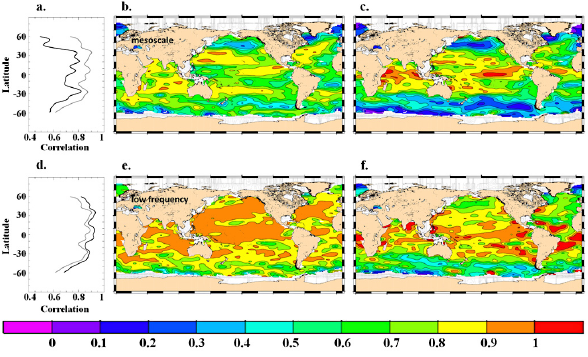
Fig. 5. Depth to which it is sufficient to integrate the DHA signals in order to explain 80% of the variance of the DHA calculated with a 1000m depth reference level (the scale range from − 1000 to